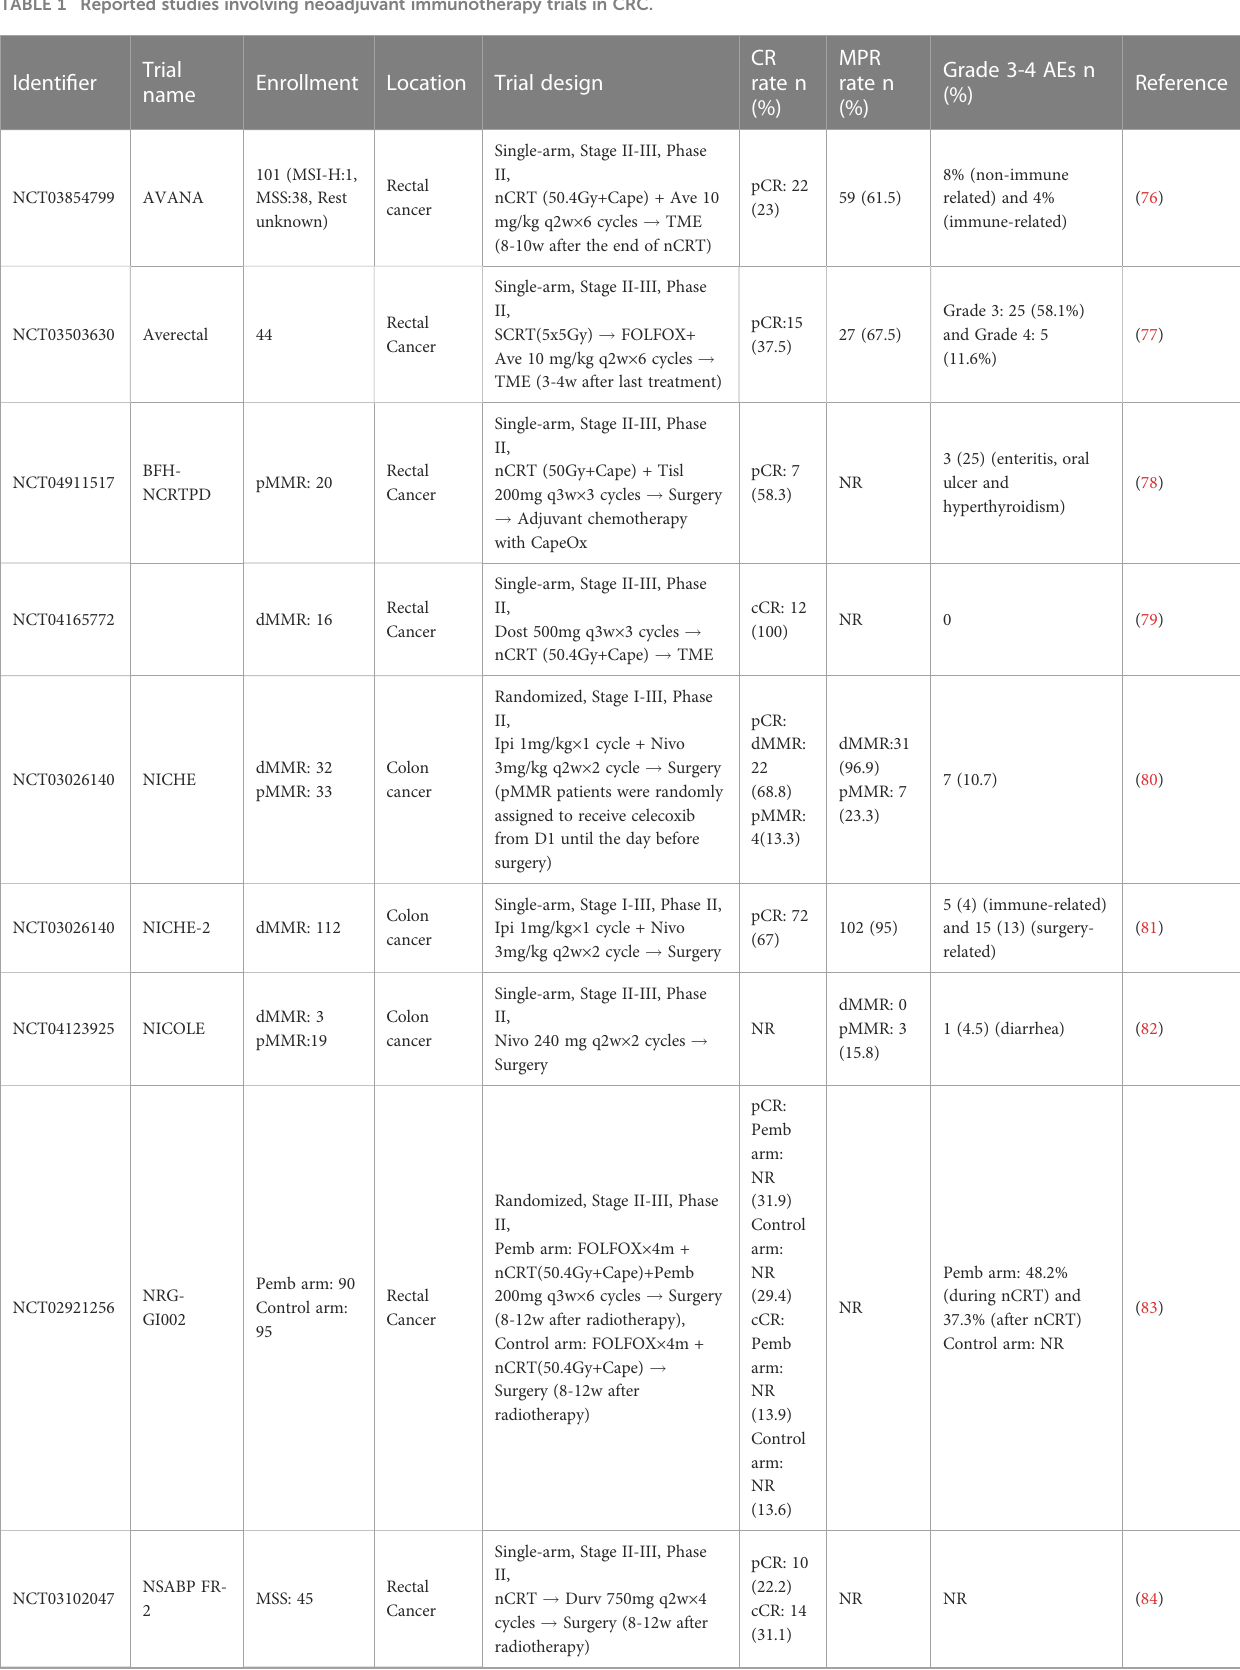
TABLE 1 Reported studies involving neoadjuvant immunotherapy trials in